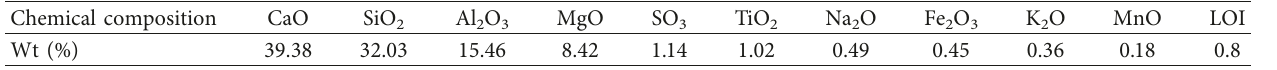
Table 1: The chemical composition of